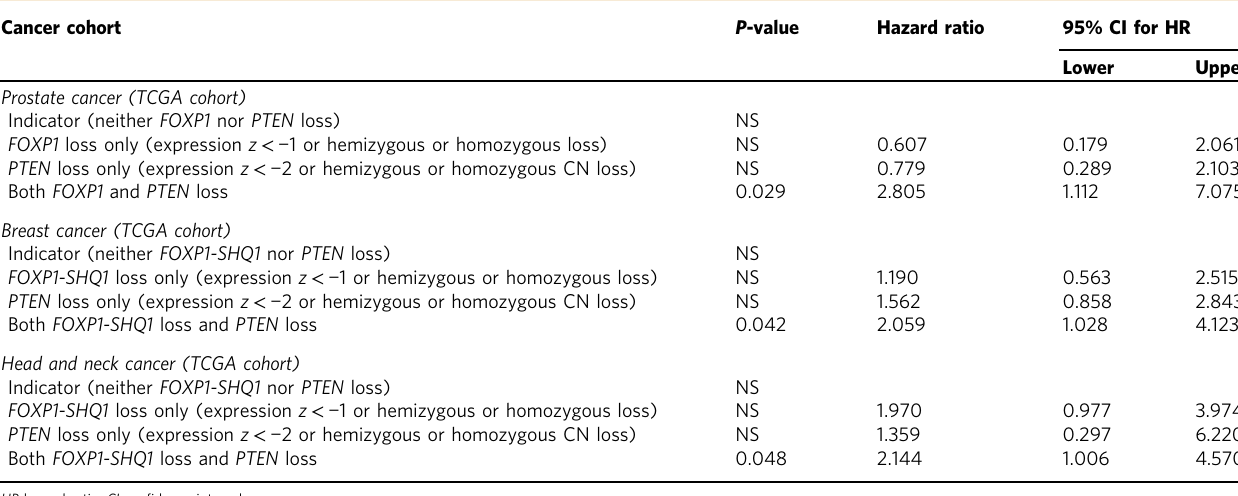
Table 1 Combined PTEN loss and SHQ1-FOXP1 loss is associated with recurrence in primary prostate, breast, and head and neck cancer by multivariate Cox regression in TCGA cohorts Cancer